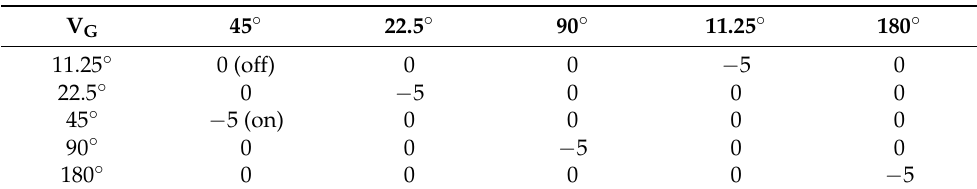
Table 1. Truth table of 5-bit X-band phase shifter.